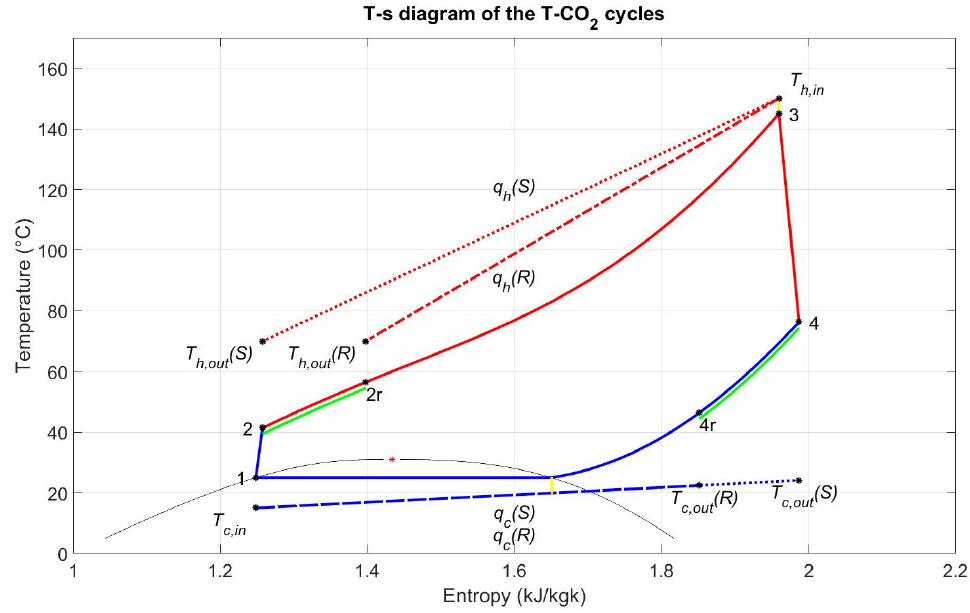
Figure 1. Temperature-entropy (T-s) diagram of the T-CO 2 cycles. (S) = Simple cycle; (R) = Recuperative cycle.